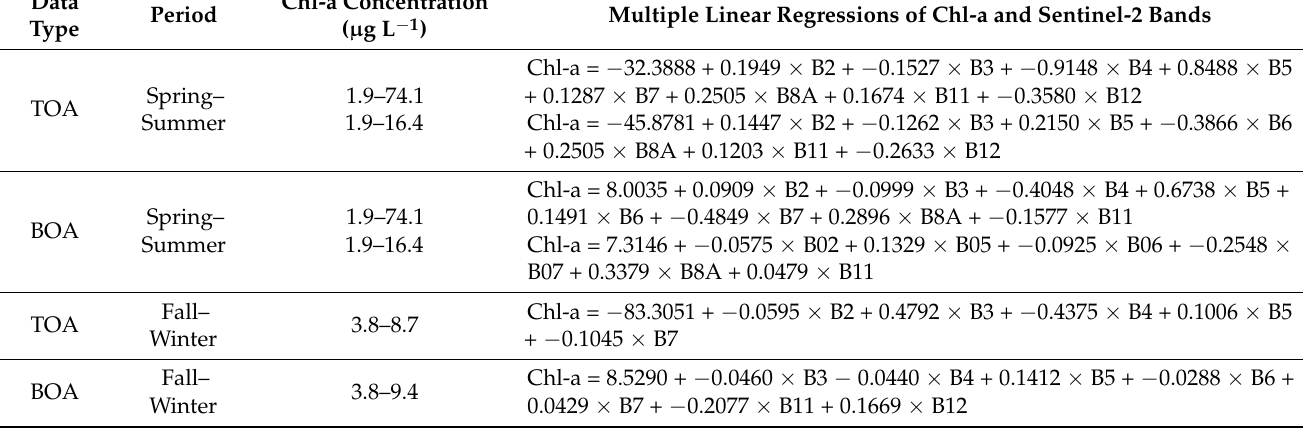
Table 4. List of multiple linear regressions used to calculate Chl-a ( µ g L − 1 ) in this